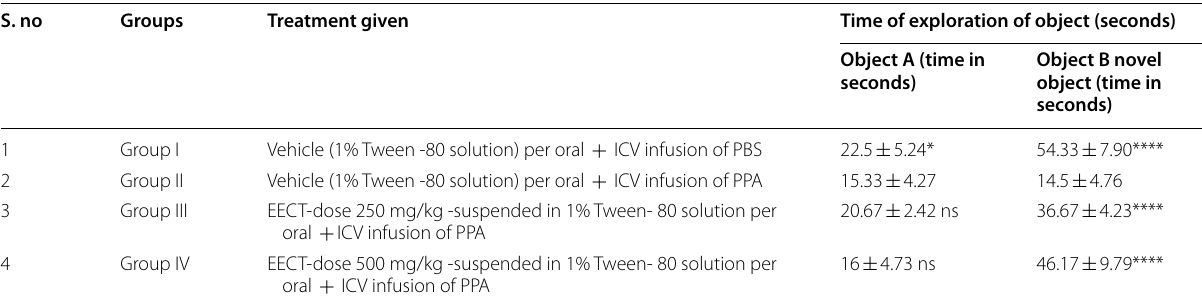
Table 2 Effect of EECT on novel object recognition